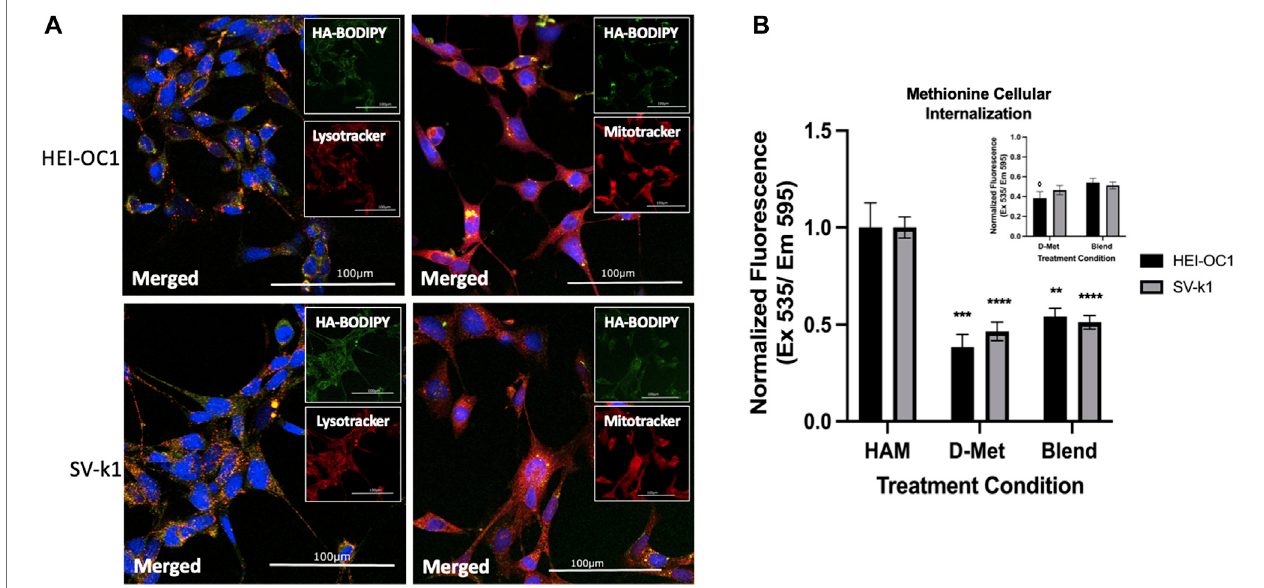
FIGURE 6 | Cellular internalization of HAM. (A) Intracellular localization of internalized HA in HEI-OC1 and SV-k1 cells, top and bottom respectively. All scale bars 100 μ m . HEI-OC1 cells with DAPI (blue), HA-BODIPY (green), and organelle tracker lysotracker on left and mitotracker on right (red). SV-k1 cells with DAPI (blue), HA- BODIPY(green),andorganelletrackerlysotrackeronleftandmitotrackeronright(red). (B) Quanti fi cationoftheintracellularamountofD-Met.Datapresentedaremean± SD. One-way ANOVA with multiple comparisons comparing cell types separately. HEI-OC1 ANOVA D-Met treated versus HAM treated p = 0.0003 and blend versus HAM p = 0.0015. SV-k1 ANOVA D-Met treated versus HAM treated p < 0.001 and blend treated versus HAM treated p < 0.0001. Inset graph is just D-Met and blend treated cells.Studentt-tests indicated with ◇ isasigni fi cantdifference betweenD-Met and blendtreatedcells ( p =0.0238). Nosigni fi cantdifferencebetweenSV- k1 cells treated with D-Met or blend ( p = 0.2397).